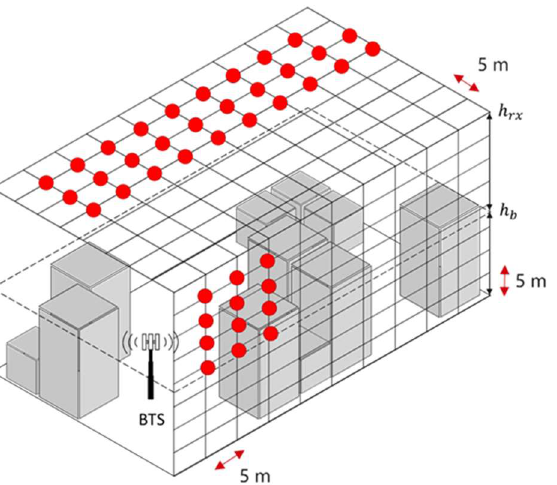
Figure 16. Layout of receivers in the ray-tracing simulation. Notice that only some of the receivers are indicated in red.